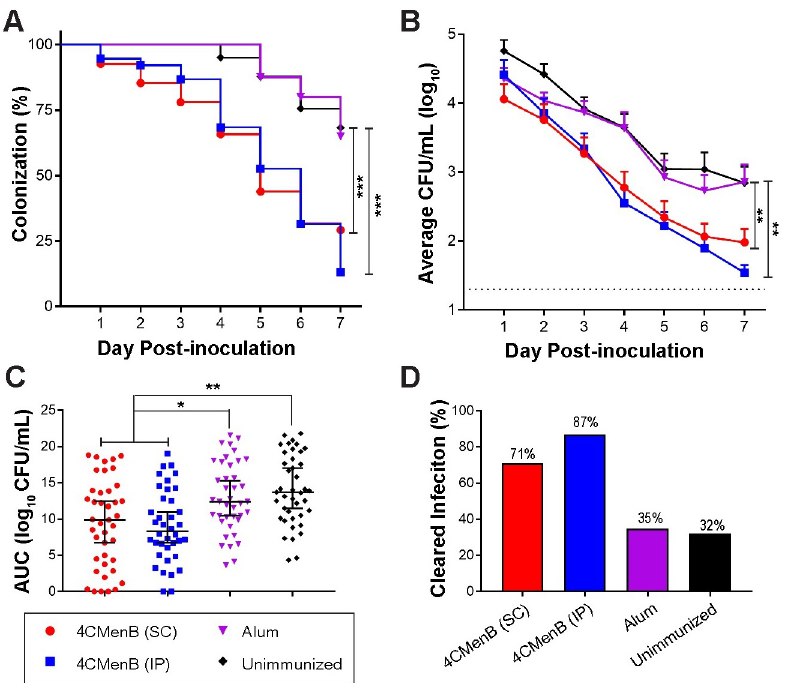
Fig 2. 4CMenB has in vivo efficacy against Ng . Mice were immunized three weeks apart with 250- μ L doses of 4CMenB by the IP (blue) or SC (red) route or with PBS (black) or alum (purple) by the IP route and challenged with Ng strain F62 three weeks after the final immunization. Shown are the combined data from two independent trials (total n = 38–41 mice/group). (A) Percentage of culture-positive mice over time; (B) Average CFU per ml of a single vaginal swab suspension; (C) total bioburden over 7 days expressed as area under the curve; (D) Percentage of mice that cleared infection by day 7 post-challenge. � , p < 05; �� , p < 0.01; ��� , p <